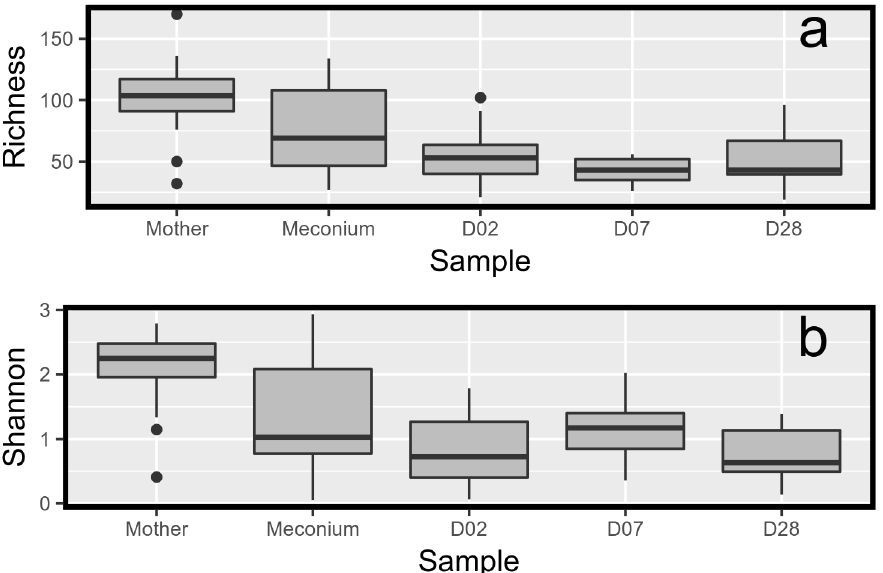
Fig 2. Diversity index changes. Diversity index changesduringthe first month of life and between mothers and infants. a: Generic richness. b: Shannondiversity index.